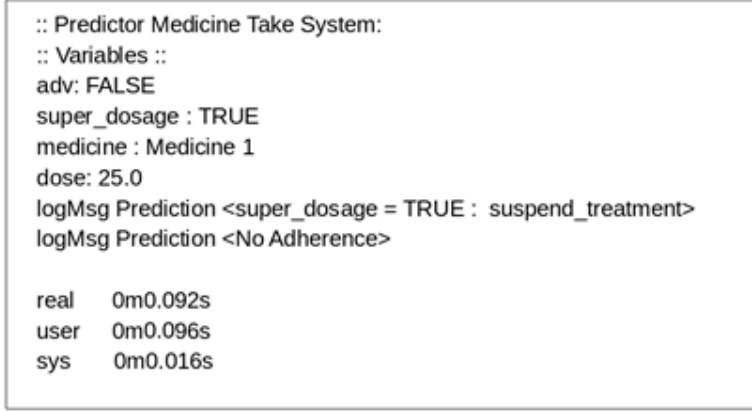
Figure 9. Decision-making system log.